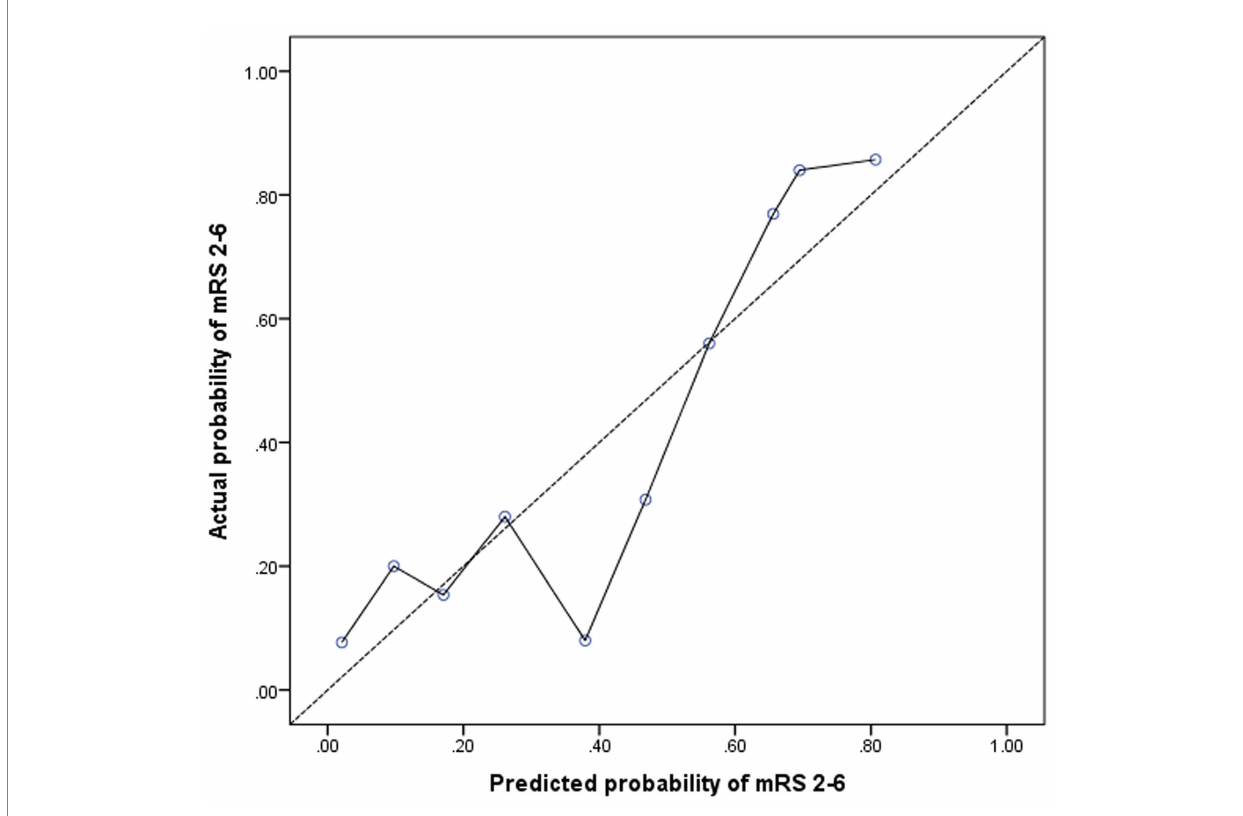
FIGURE 4 Calibration plot for the model containing age, systolic blood pressure, NIHSS score, TOAST classification, and nTreg/mTreg ratio. A calibration slope of 1.0 indicates perfect calibration (dotted line). nTreg, naïve regulatory T cells; mTreg, memory regulatory T